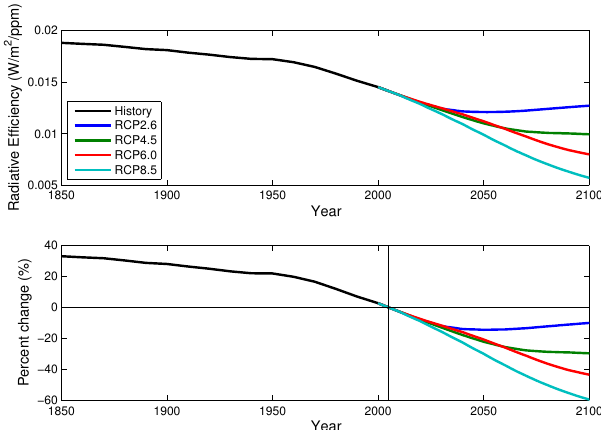
Fig. 4. The radiative efficiency (RE) for CO 2 as a function of con- centration for the historic period and the Representative Concen- tration Pathways (RCPs) to be used in the IPCC Fifth Assessment Report. Constant current (2005) concentrations are represented by the 0% line.